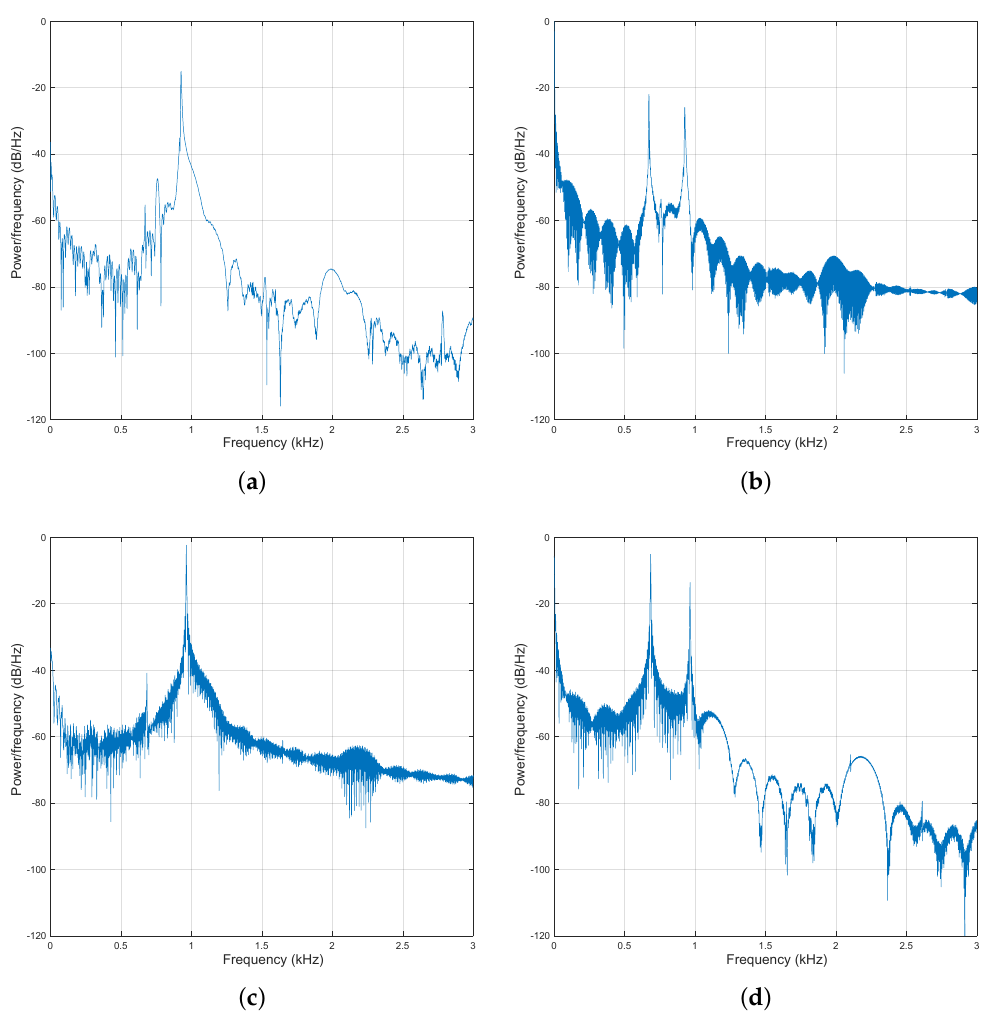
Figure 10. Power spectral density estimate of the displacement of node A. ( a ) Stable case; ( b ) stable case; ( c ) unstable case; ( d ) unstable case.